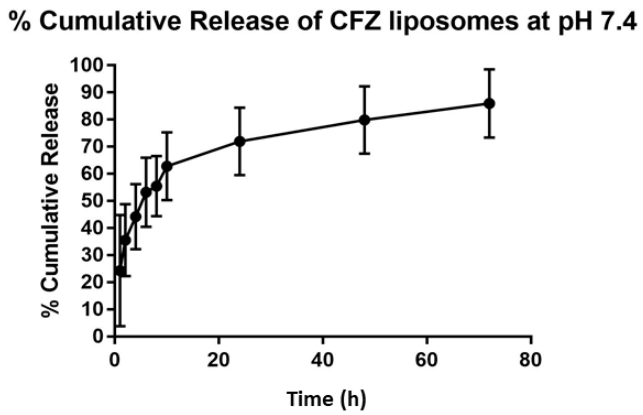
Figure 3. % Cumulative release of CFZ liposomes at pH 7.4.